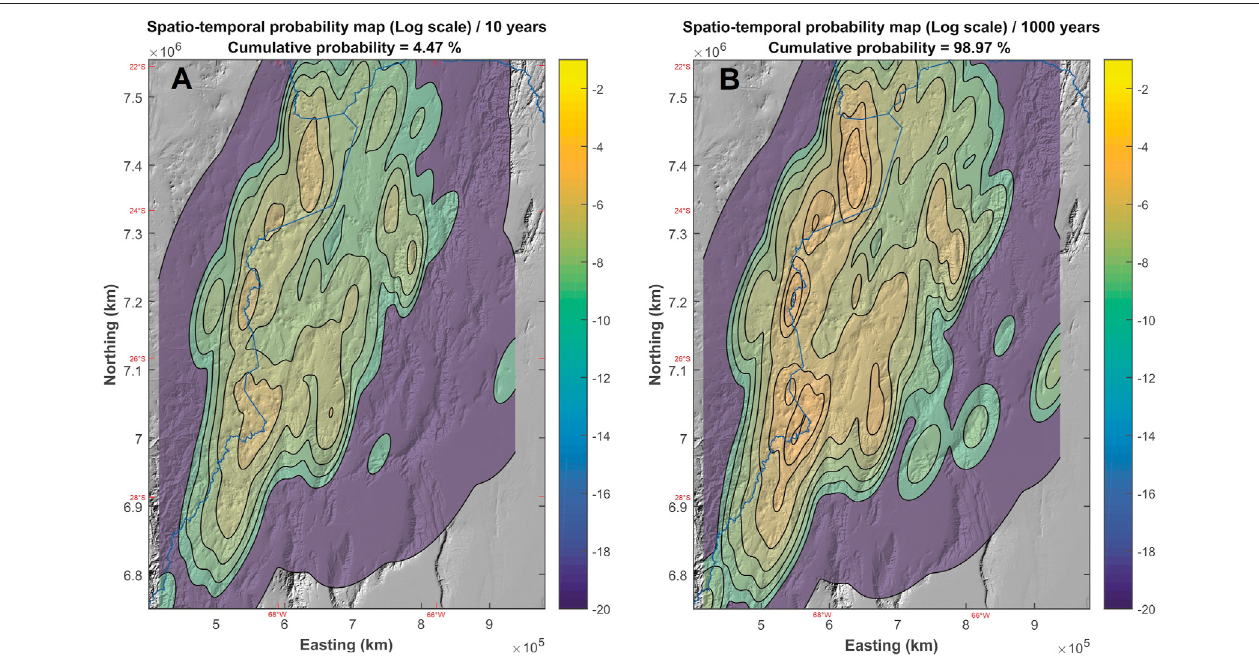
FIGURE 4 | Spatio-temporal probability maps of future volcanic activity for our study area at different forecasting time intervals. Probabilities were obtained after multiplying the spatial probability map shown in Figure 3A by the event recurrence rate (45.77 events per 10 kyr) modeled as a homogeneous Poisson point process, and are shown as probability isocontours on a logarithmic scale to illustrate order-of-magnitude changes. Above each plot we include the cumulative probabilities of occurrence of at least one Láscar 1993-like (i.e., 0.1 km 3 ) eruption for thenext: (A) 10 years, and (B) 1,000 years, with 1993taken as ‘ year zero ’ . Legend units are events/time interval/km 2 . The political border between Chile, Argentina and Bolivia is depicted for reference (blue line). ASTER Digital elevation model used as a background image follows a greyscale colour scheme: the whiter the pixel, the higher the elevation.